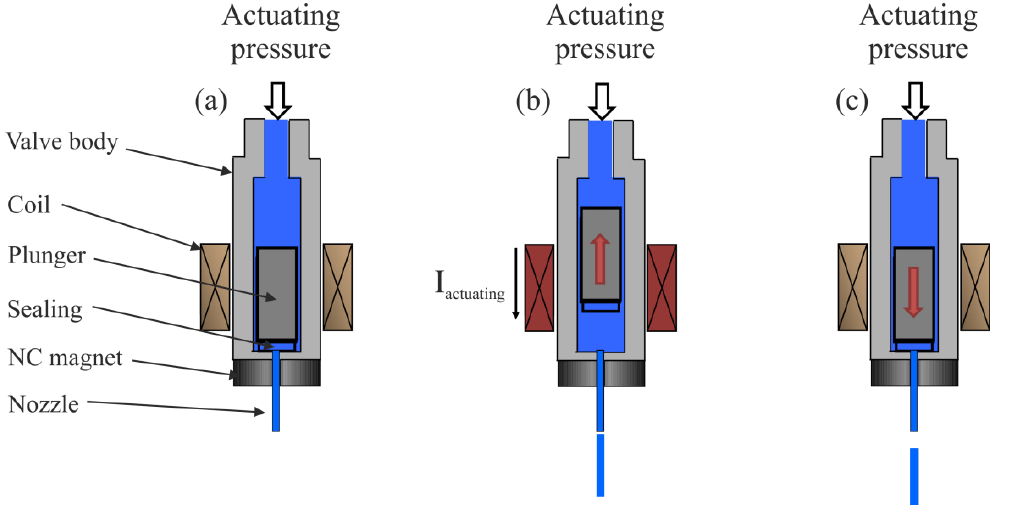
Figure 1. Working principle of the normally-closed, electromagnetic dispensing valve. In its initial state ( a ), the magnetic plunger is attracted by the normally-closed (NC) magnet. The valve is sealed by a thin silicone layer at the bottom of the plunger which is in contact with the sharp-edged nozzle. A current I actuating will generate a magnetic field forcing the plunger to move up ( b ). After a defined actuation time, the current I actuating is turned off and the valve is closed by the attracting force of the NC magnet ( c